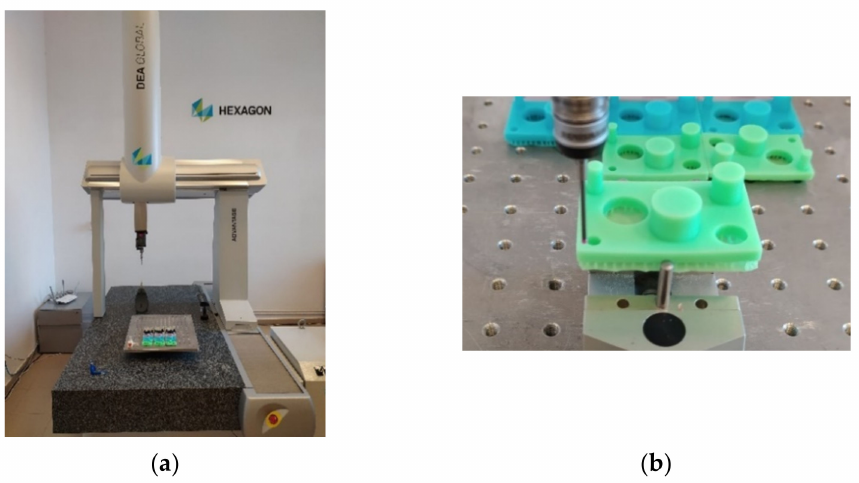
Figure 1. The coordinate measuring machine used to measure the printed parts: ( a ) view of the 3D printed parts; ( b ) clamping the